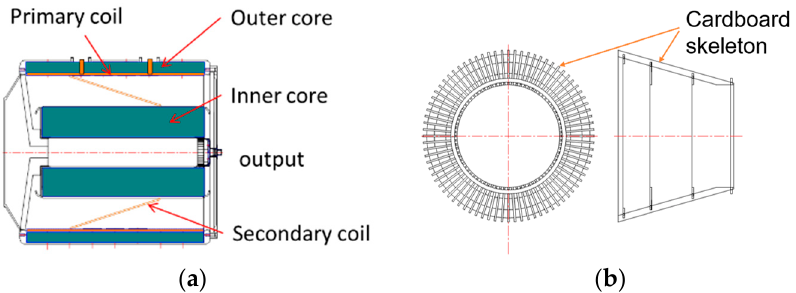
Figure 7. Structure of the partial core transformer. ( a ) Cross-section of the Transformer; ( b ) The cone skeleton made of cardboard.